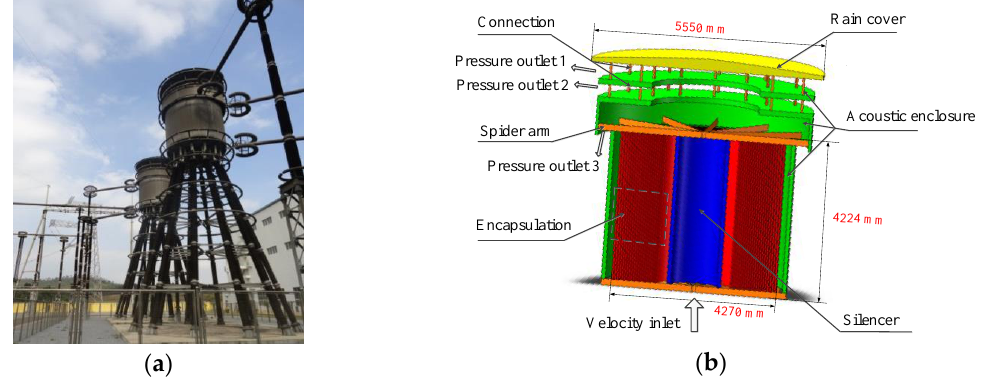
Figure 1. Structural diagram of a reactor’s main body and calculation model: ( a ) ±800 kV-DASR; ( b ) the model structure.